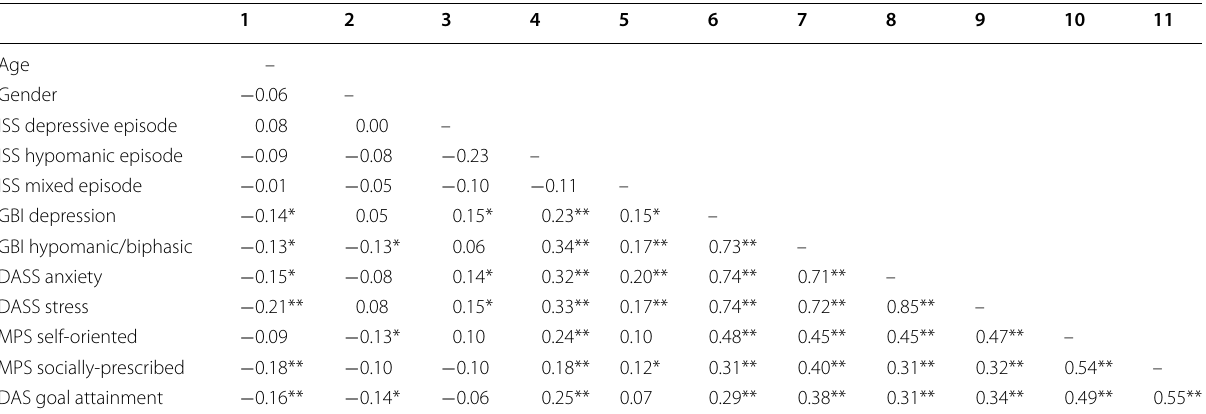
Table 2 Zero-order correlations for all variables